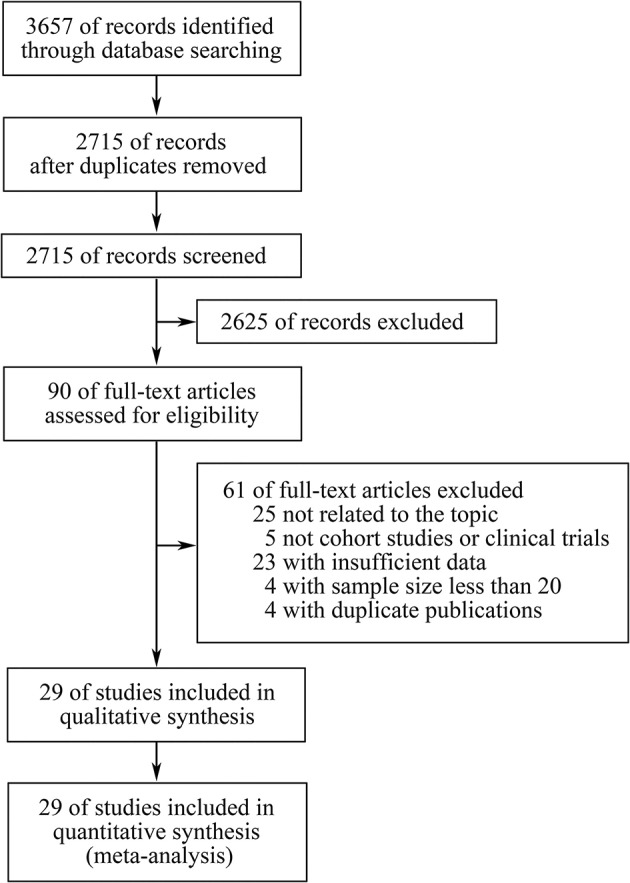
The PRISMA flow diagram.